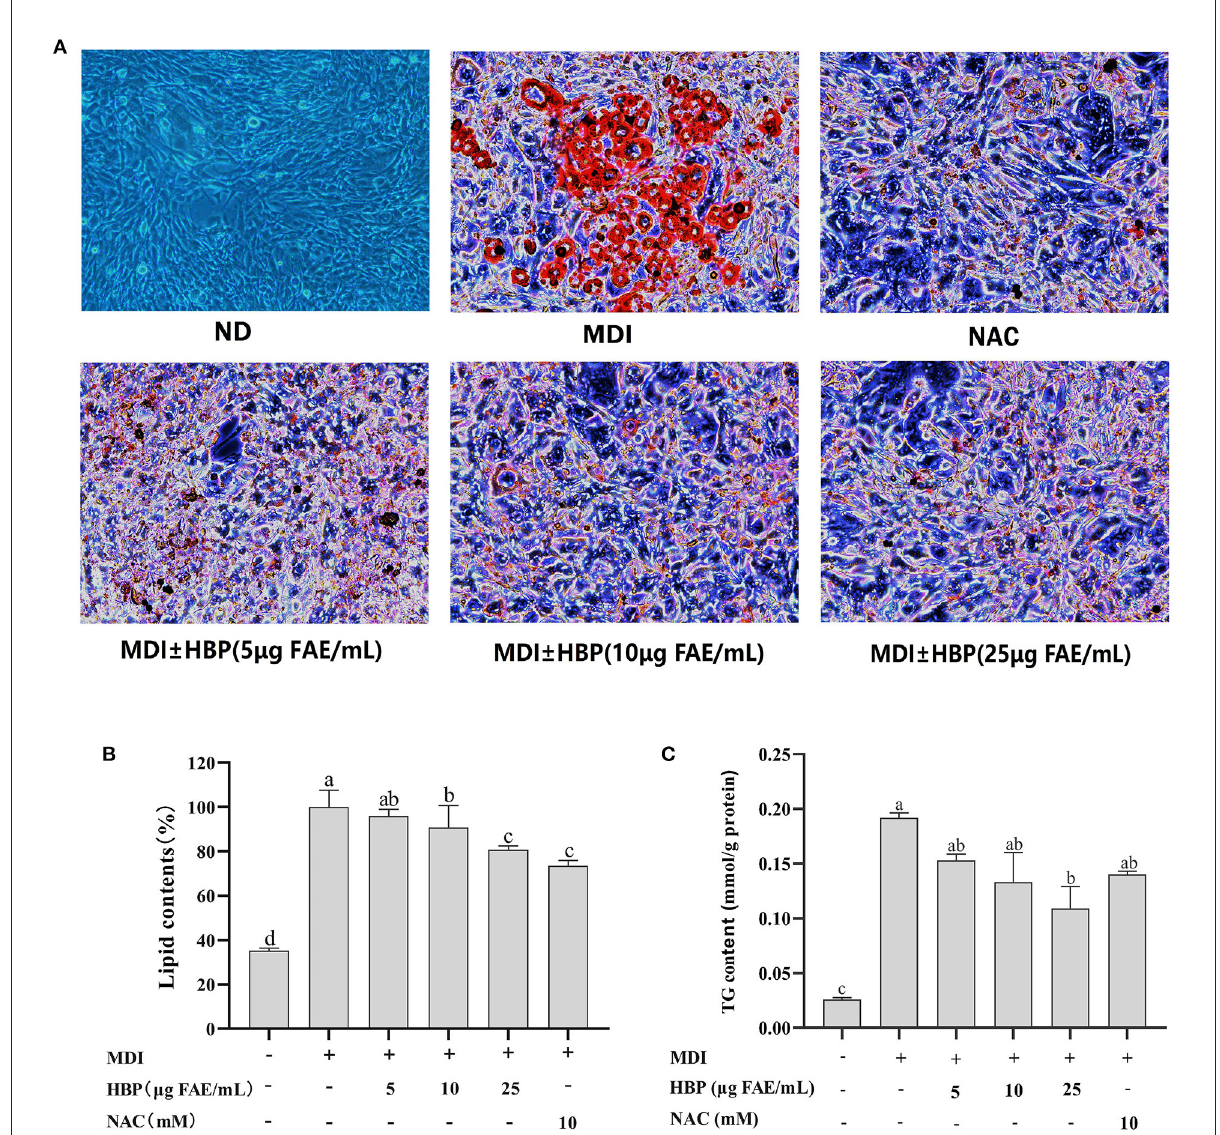
FIGURE3 Effects of HBP extract on adipocyte differentiation in 3T3-L1 cells. (A) 3T3-L1 preadipocytes were cultured in a differentiation medium containing 5, 10, and 25 µ g FAE/mL for 48h. The cells were then stained with oil red O staining solution. “ND” means that cells were cultured in a normal medium without HBP extract. “MDI” means that cells were cultured in a differentiation medium. NAC was used as a positive control group. (B) The cells stained with Oil red O were subjected to quantitative analysis of the intracellular lipid accumulation. (C) HBP extract inhibited TG accumulation in 3T3-L1 adipocytes. All values are presented as the mean Different letters indicate significant differences at p <